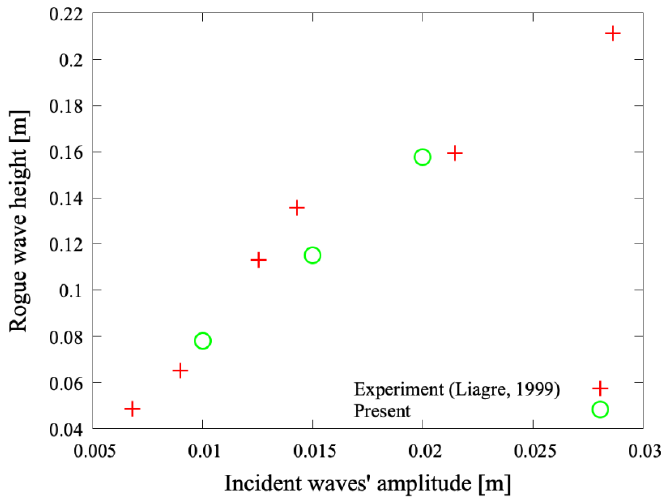
Figure 8. Simulated rogue wave height.